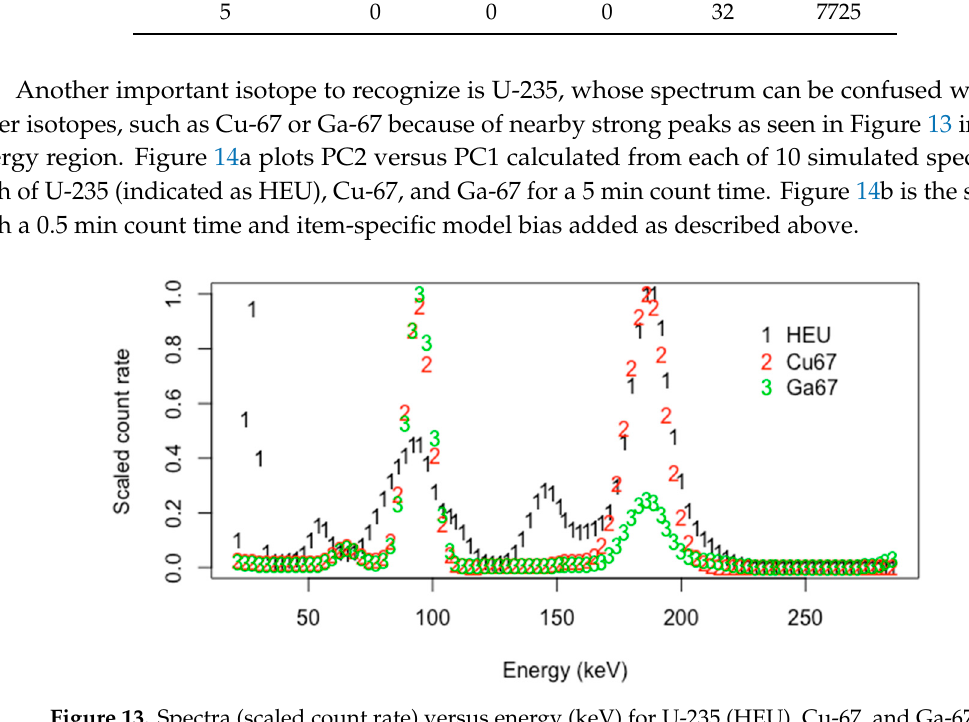
Figure 14. PC 2 versus PC 1 for U-235 (HEU), Cu-67, and Ga-67 for ( a ) 5 min count time without model bias and ( b ) 0.5 min count time with item-specific variation in the model bias. For 1000 test cases of each of U-235, Cu-67, and Ga6-7, the Figure 13 spectra lead to 100% correct classification in the Figure 14a case (5 min count time and no model bias). For 1000 test cases of each of U-235, Cu-67, and Ga-67, the Figure 13 spectra lead to 90% correct classification in the 14b case (0.5 min count time and model bias) and an average confidence (probability that the guessed group is correct) was also 90%, indicating good ABC calibration. For the 1000 test U-235 cases, 895 were predicted to be U-235, 103 were predicted to be Cu-67, and 2 were predicted to be Ga-67. The scaled count rate in each of 20 equally spaced energy bins were used as summary statistics (peak areas were not explicitly extracted), and there has not yet been an attempt to optimize performance by experimenting with candidate summary statistics, because all of the example RIID applications are for illustration only. 7. Discussion and Summary A new ABC-based RIID was developed. The results show that the ABC-based RIID is well calibrated and that ABC is effective for inferring peak location, width, and area, which are key steps in peak-based RIID algorithms. It is important to recall that the simulated spectra are clearly distinct from the corresponding real spectra. Therefore, the forward model used in ABC, such as that in GADRAS [21] or that in Equation (1), has model bias that was addressed by comparing real to simulated spectra. More comparison of real to simulated spectra should be a next step. As real experiments with RIIDs become more costly, simulated data are likely to be more extensively used. Recall that already in practice, one quality check used by some RIIDs is whether simulated data agree reasonably well with the observed data; if so, there is reasonable confidence that the inferred subset is at least close to correct. However, simulation model bias is not yet considered in any existing